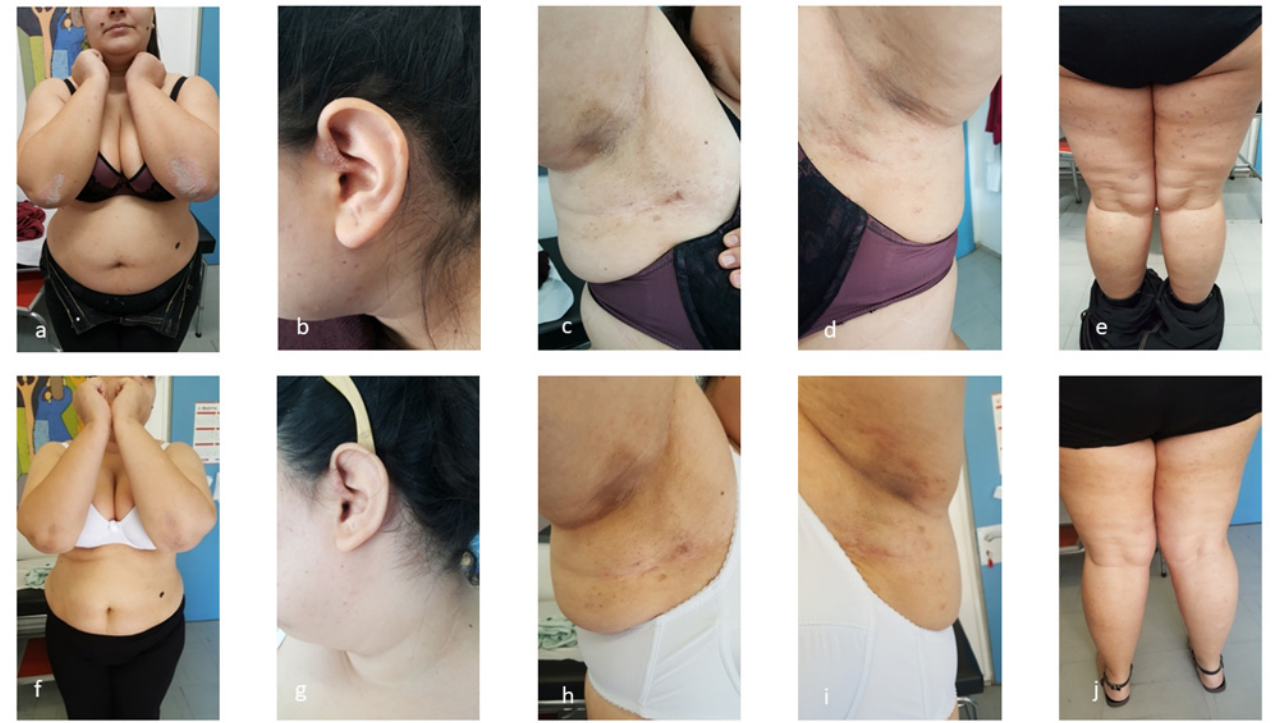
Figure 1. Psoriatic and HS lesions of patient 1. ( a – e ) Psoriatic and HS lesions of first patient before treatment with certolizumab pegol. ( f – j ) Psoriatic and HS lesions of first patient after treatment with certolizumab